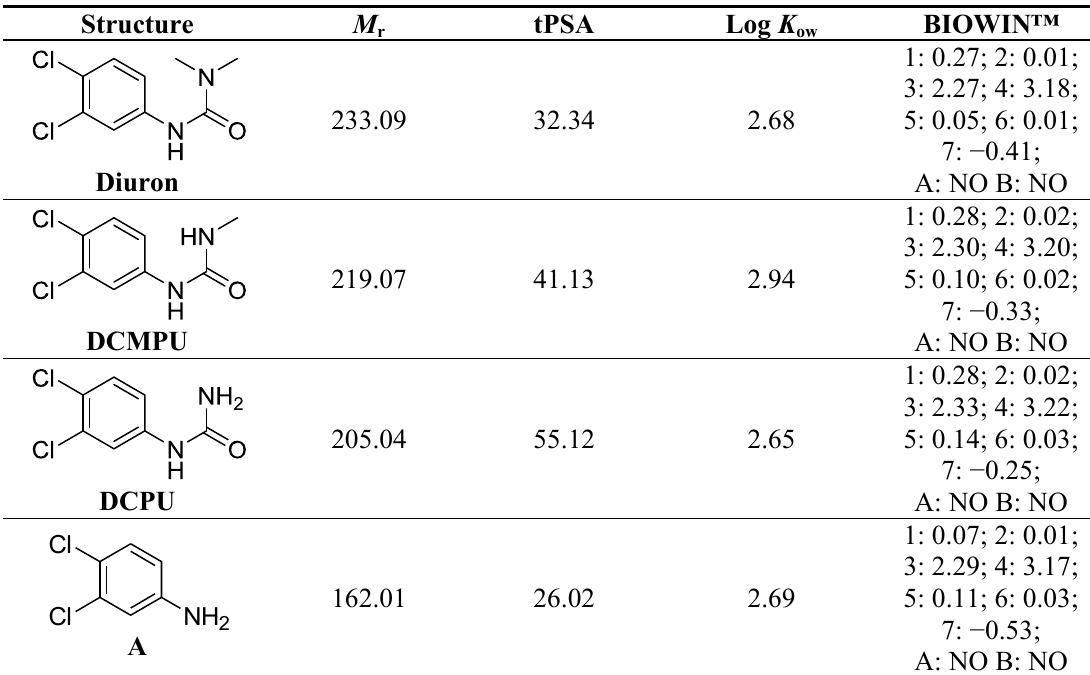
Table 3. BIOWIN™ calculations for Diuron and metabolites. M = molecular weight; r tPSA = total polar surface area; Log K = log of water/octanol partition coefficient. ow * Log K values calculated using KOWWIN. BIOWIN™ models: 1-linear, 2-non-linear, ow 3-ultimate, 4-primary, 5-linear MITI, 6-non-linear MITI, 7-anaerobic; Criteria A-model 2 or 6 > 0.5 and model 3 > 2.2; Criteria B-model 3 “weeks” or faster and model 5 > 0.5. Letters correspond to structures in Figure